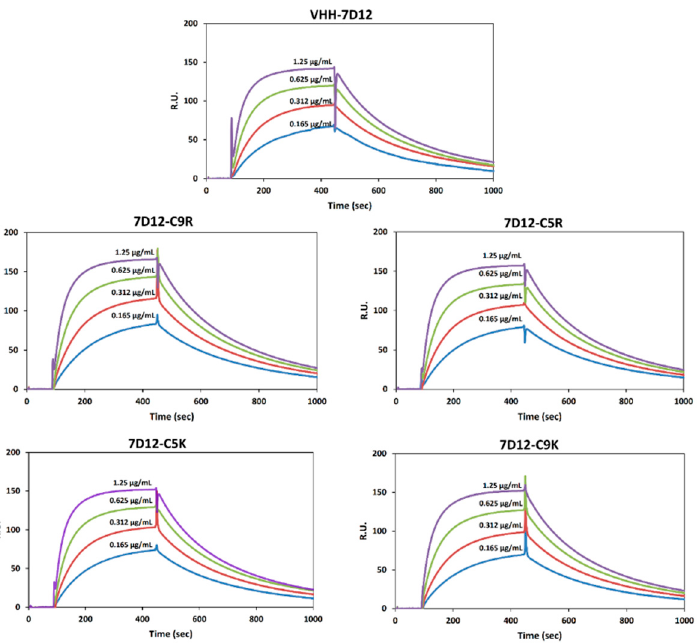
Figure 3. Binding activity of V HH -7D12 variants to EGFR using SPR: EGFR extracellular domain (20 µg/mL) was immobilized onto a CM5 sensor chip. The binding activity of tagged and untagged V HH -7D12 variants was analyzed at concentrations between 0.165 µg/mL and 1.25 µg/mL in HBS-EP buffer containing 1.5 M NaCl. Table 1. Midpoint unfolding temperature ( T m) and binding affinity at 20 °C of V HH -7D12 variants. Variants